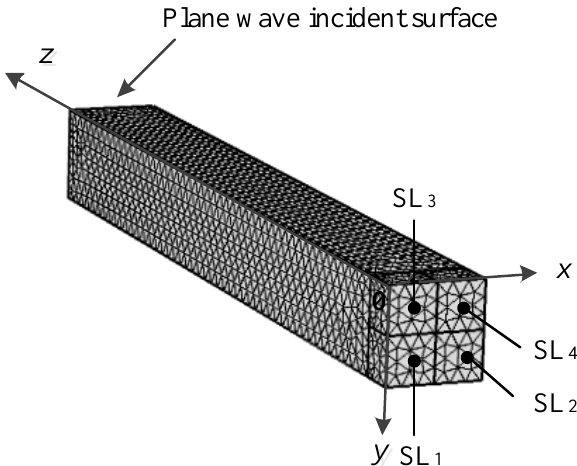
Figure 2. The finite element model of four shunted loudspeakers in parallel.